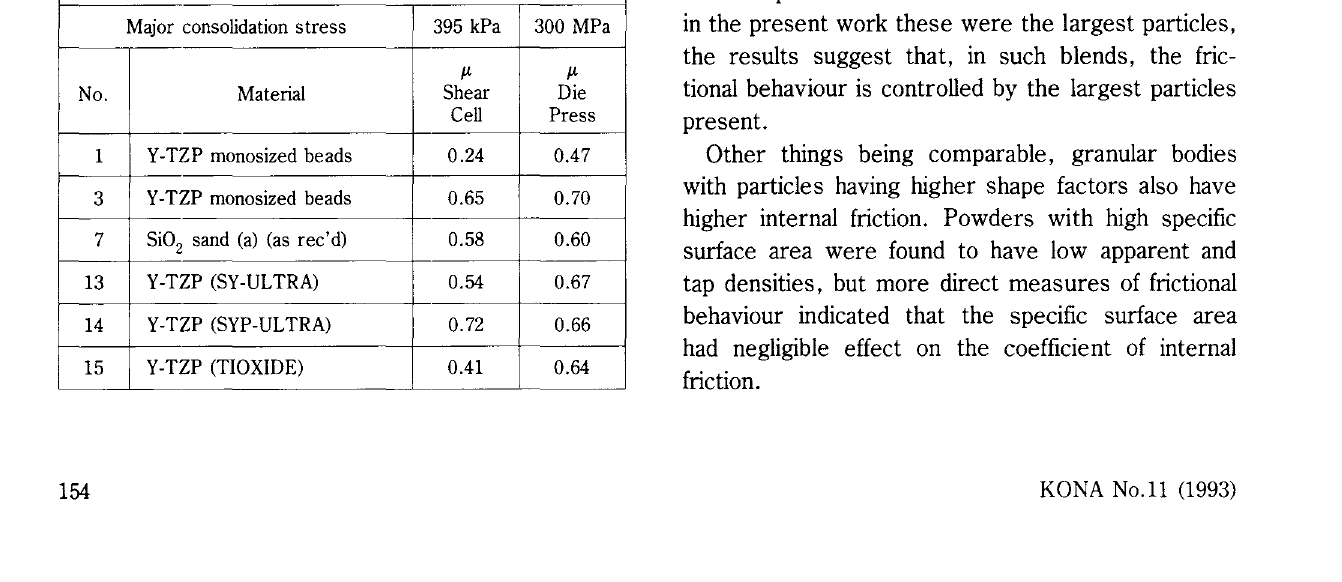
TABLE 7 - LOAD EFFECT ON INTERNAL